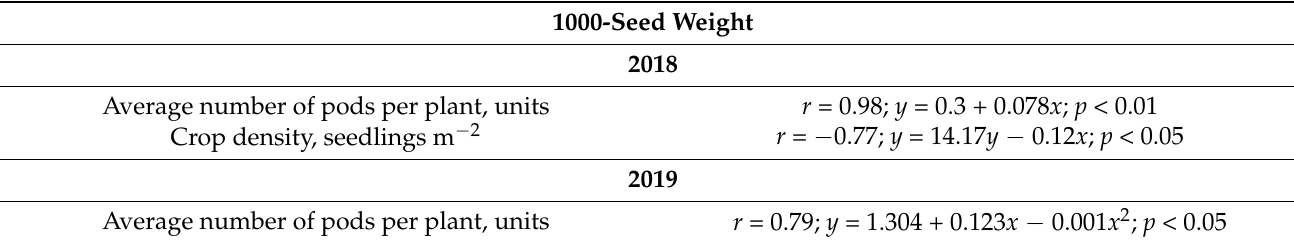
Table 5. Correlation between the spring rapeseed 1000-seed weight ( y ) and number of pods per plant, and crop density ( x ),